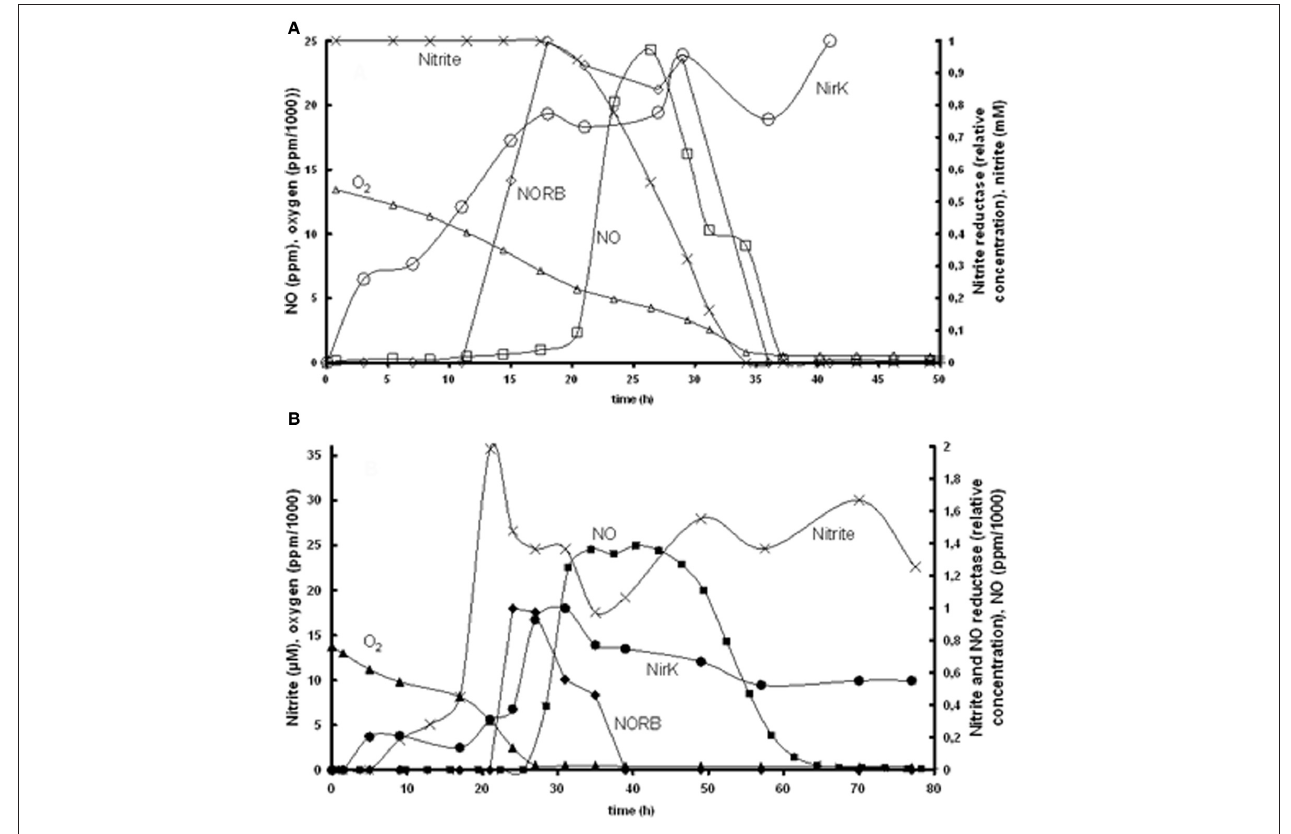
FIGURE 2 | Measured nirK and norB transcription together with concentrations of nitrate, nitrite, N 2 O, and O 2 in time. (A) Experiment with 1% gas phase oxygen and 1mM nitrite: nitrite ( × ), NirK ( (cid:4) ), NORB ( ♦ ) NO ( (cid:3) ), oxygen ( (cid:5) ). (B) Experiment with 1% gas